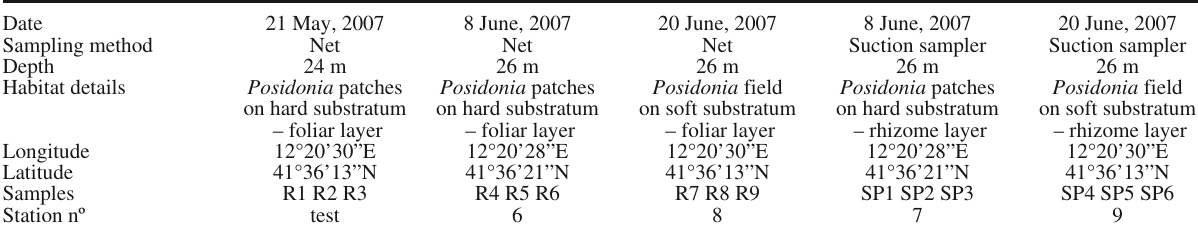
Table 1. – Station list, Marine Protected Area “Secche di Tor Paterno”, Central Tyrrhenian Sea, Italy.